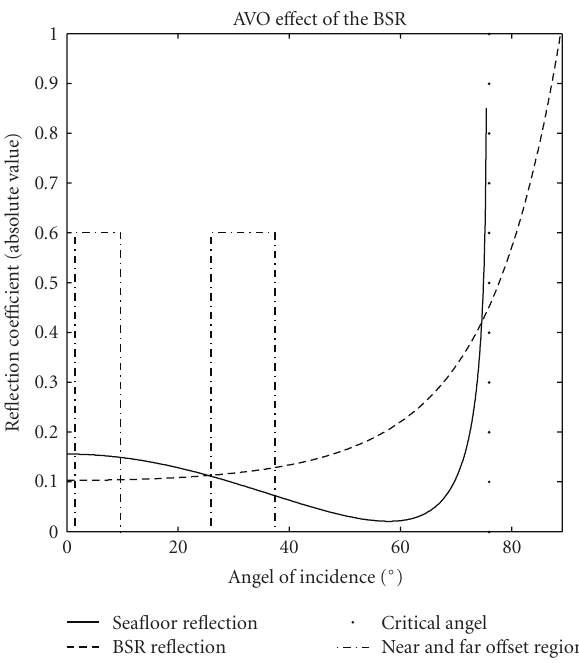
Figure 5: The magnitudes of the reflection coe ffi cients for the seafloor reflection and the BSR are calculated for a model with ∼ 3% free gas below the gas hydrate stability zone [44]. Density and seismic velocities are taken from the full-waveform inversion of Pecher et al. [9]. The black boxes mark the incident angle ranges which are shown in Figure